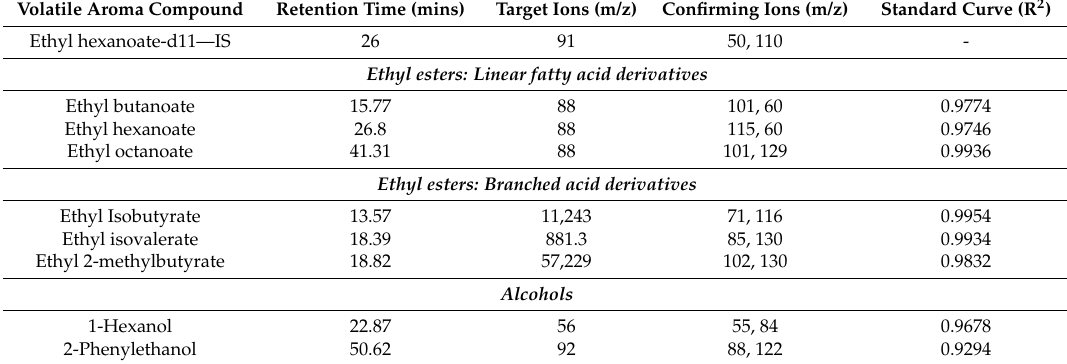
Table 2. Summary of parameters for volatile aroma compound